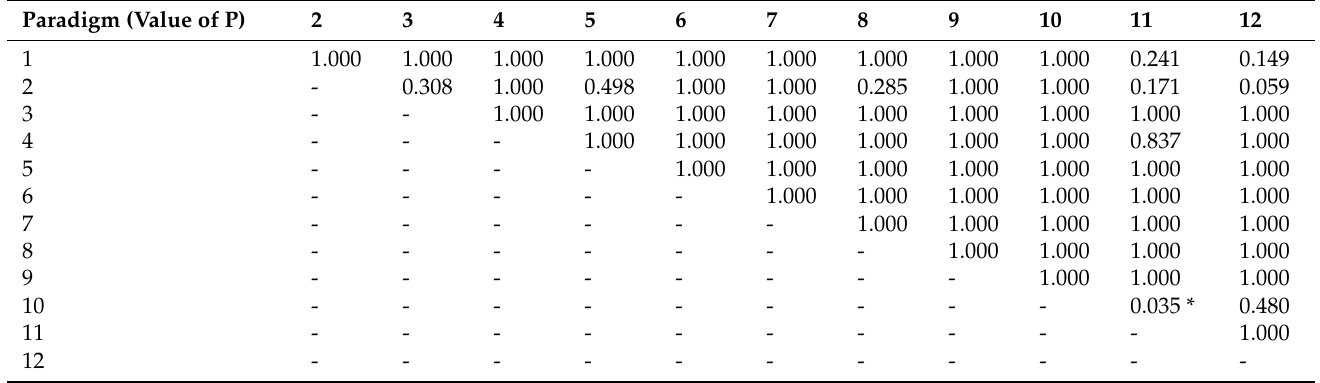
Table A2. Bonferroni Post-Hoc Analysis of Likert Scale of Visual Fatigue Scale among Twelve Paradigms.